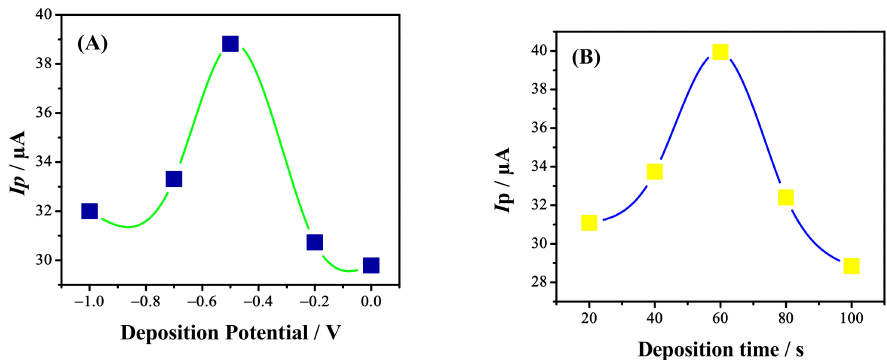
Figure 9. ( A ) The effect of the deposition potential on the oxidation peak current of VEN, keeping the deposition time constant (60 s), and ( B ) the effect of the accumulation time on the oxidation peak current maintaining its accumulation potential ( − 0.5 V) for Co–Pd@Al 2 O 3 /GCE in the 2 µ M solution of INZ by applying the SWASV technique.